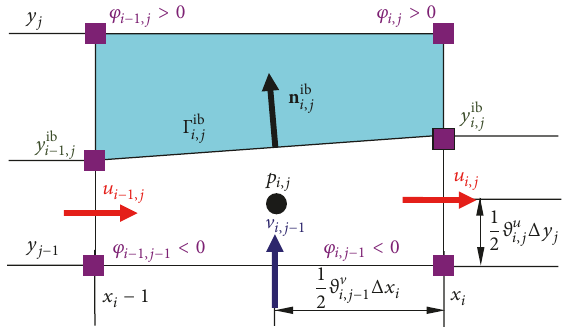
Figure 3: Example of a